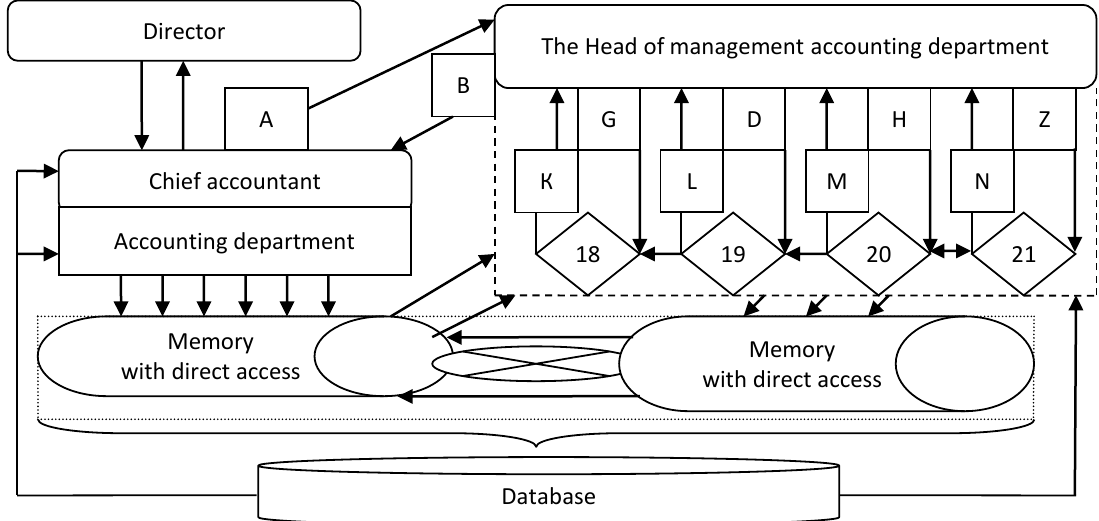
Figure 2. Recommended distribution of powers and semantics of the accounting information system of budgetary institutions focused on